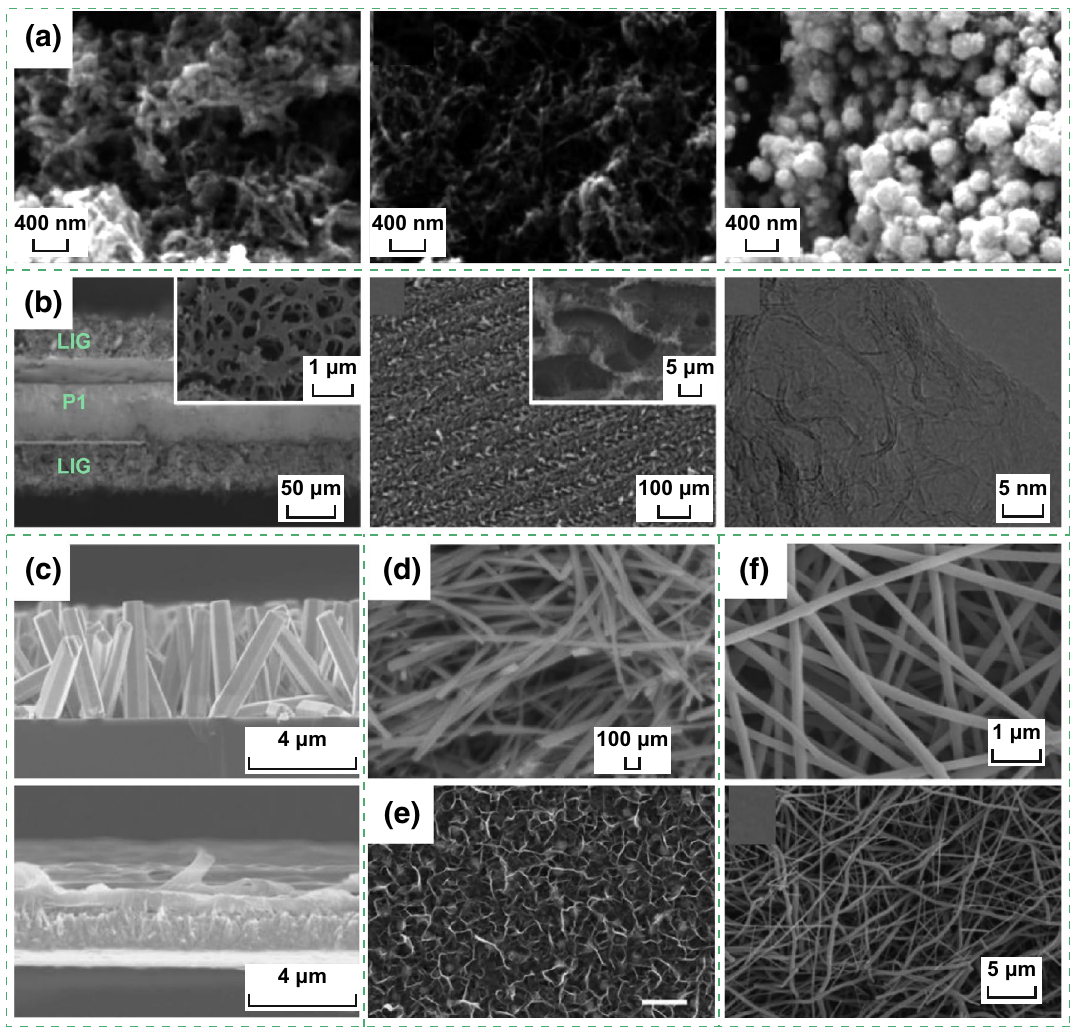
Fig. 2 a SEM images of PANI/CNT, unmodified or PtNP‑modified PPy/CNT surfaces. Reprinted with permission from Ref. [14]. b Cross‑ sectional SEM image of a double‑sided laser‑engraved PI substrate with both sides of LIG, SEM image of the LIG thin film, and HRTEM image obtained from the edge of a LIG flake. Reprinted with permission from Ref. [15]. c Cross‑sectional SEM images of ZnO NW arrays and PVDF mesoporous nanostructured film. Reprinted with permission from Ref. [16]. d FESEM image of MnO 2 nanostructure. Reprinted with permis‑ sion from Ref. [17]. e SEM images of the 3D Au@MnO 2 nanocomposites (scale bar, 500 nm). Reprinted with permission from Ref. [18]. f SEM images of the LiMn 2 O 4 precursor NWs and the obtained carbon NWs. Reprinted with permission from Ref.